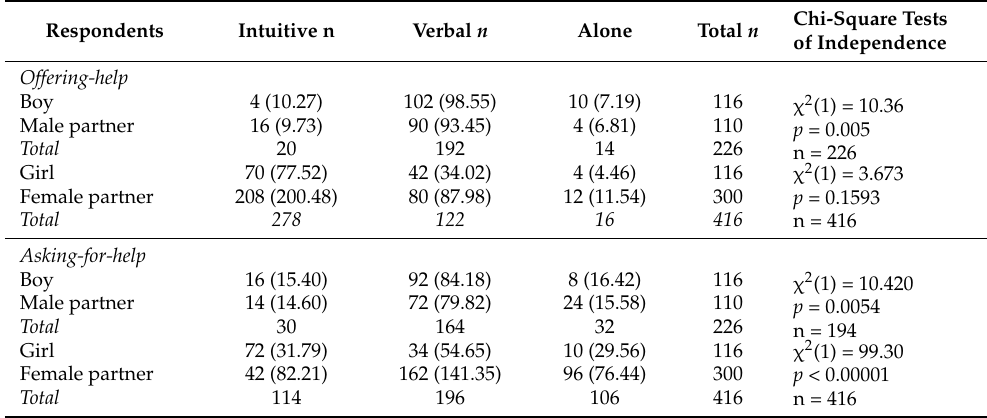
Table 4. Comparisons of the same-sex respondents by intuitive and verbal means in the condition of offering and asking for